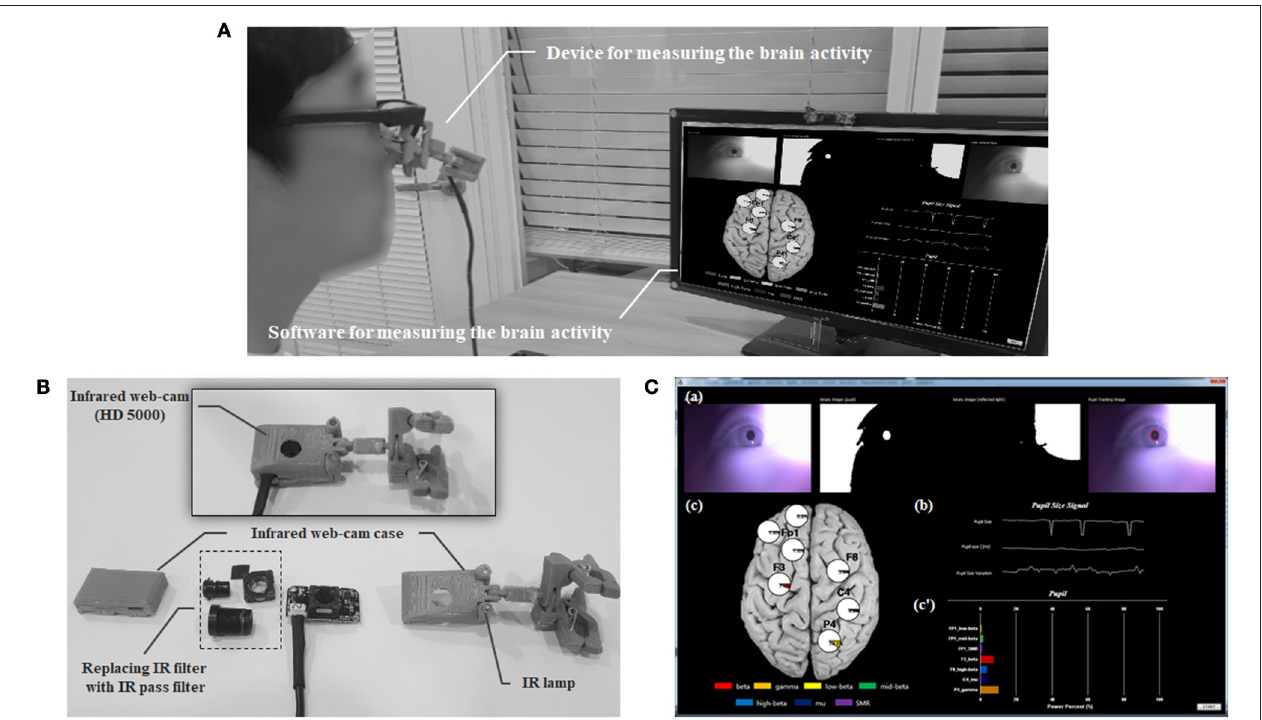
FIGURE 9 | The real-time system for measuring brain activity using an infrared (IR) web-cam. (A) Overview the real-time system. (B) Configuration of the measuring device including the web-cam. (C) Introduction to the measuring software: (a) Protocol for detecting the pupil area; (b) Pupillary response including raw, re-sampled, and filtered pupil diameter data; (c and c ′ ) Output of the relative power for the electroencephalogram spectral index (low beta power in the FP1 region; mid beta power in the FP1 region; SMR power in the FP1 region; beta power in the F3 region; high beta power in the F8 region; gamma power in the P4 region; mu power in the C4